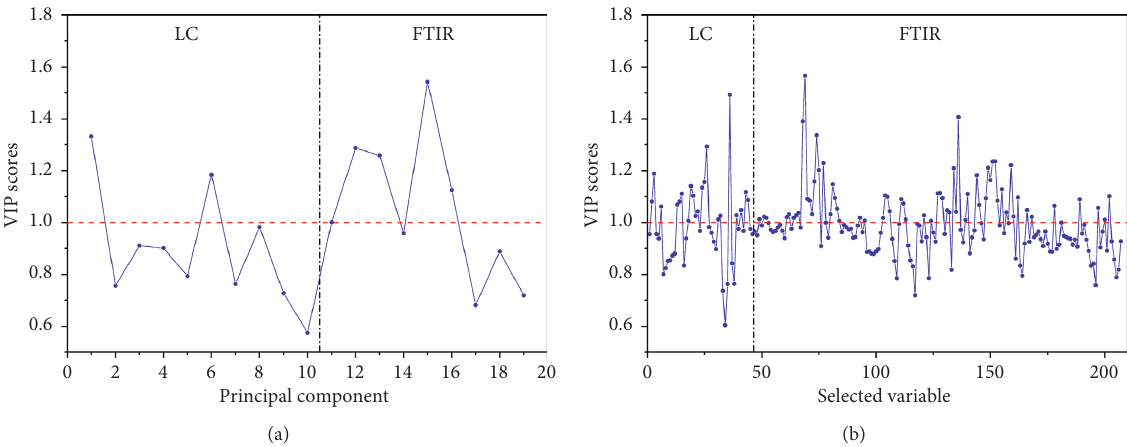
Figure 7: The VIP scores resulting from mid-level PCA (a) and mid-level Boruta (b) PLS-DA